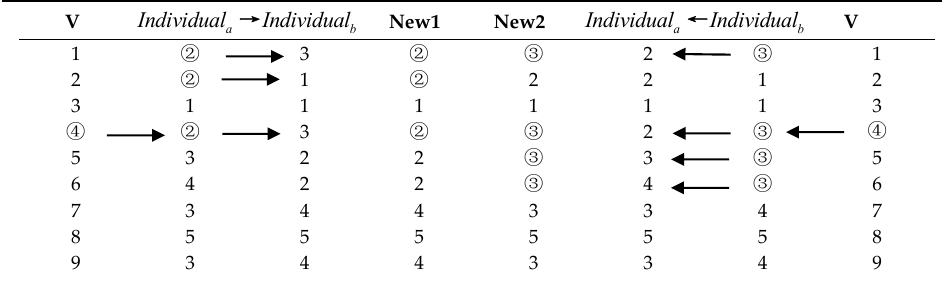
Table 1. Two-way crossover when v 4 is selected.